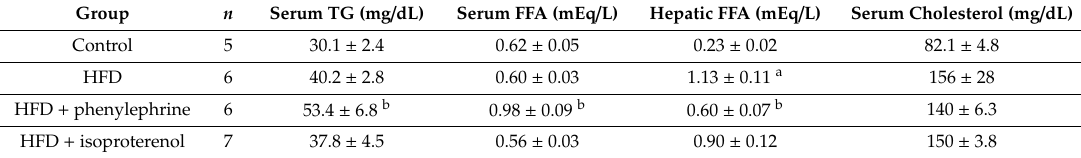
Table 2. Hepatic and serum TG and FFA contents in mice fed experimental